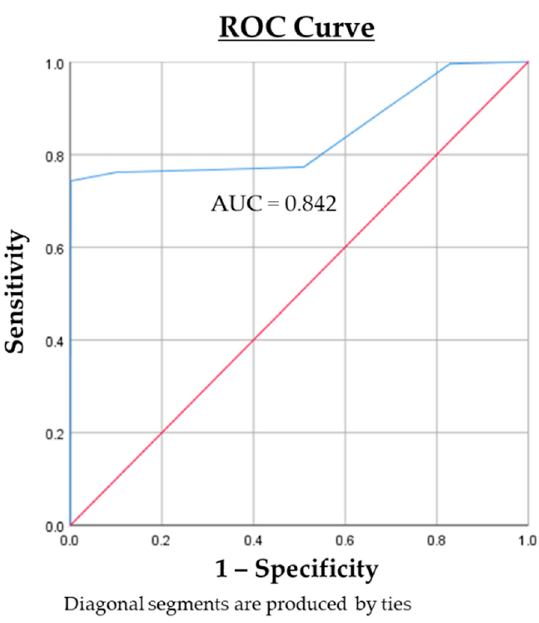
Figure 10. The receiver operating characteristics (ROC) curve and area under the curve (AUC) of the land suitability model overall performance.